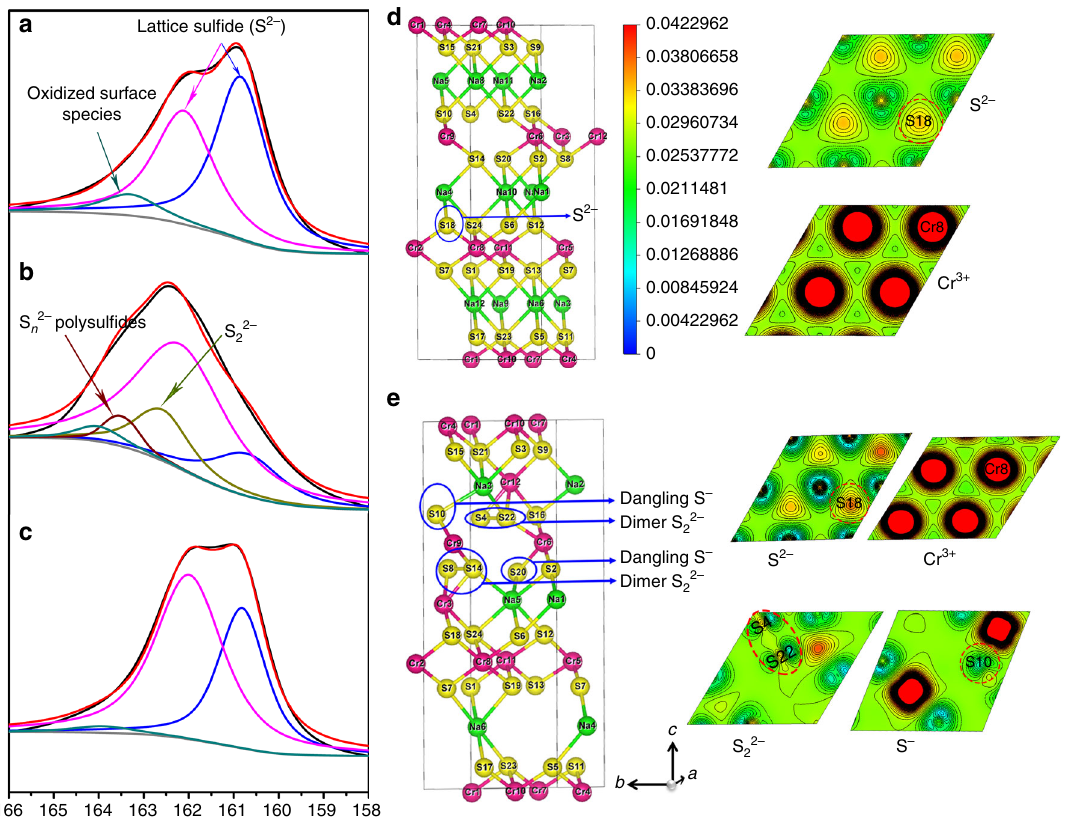
Fig. 5 Detection of S species evolution during various charge-discharge stages. S 2 p XPS spectra of NaCrS 2 samples, a pristine, b after charging to 3.0 V, and c after discharging to 1.5 V. Crystal structures and electron density contours of d pristine NaCrS 2 and e Na 0.5 CrS 2 with 1/6 Cr/V ′ Na antisite (2 × 2 × 1 conventional cells). Selected planes are through the Cr and S ions labeled in crystal structures. The contour unit is e/Bohr 3 (1 Bohr = 0.529 The ground state con fi guration of Na 1 − x CrS 2 with different Na concentrations ranging from x = 0 to x = 0.5 are determined by cluster expansion and the results are shown in Supplementary Figs. 9 – 13. Based on the ground state con fi guration of Na 0.5 CrS 2 (without Cr/V ′ Na antisite) obtained from the cluster expansion and by referring to the XRD and STEM results in Figs. 2 and 3,